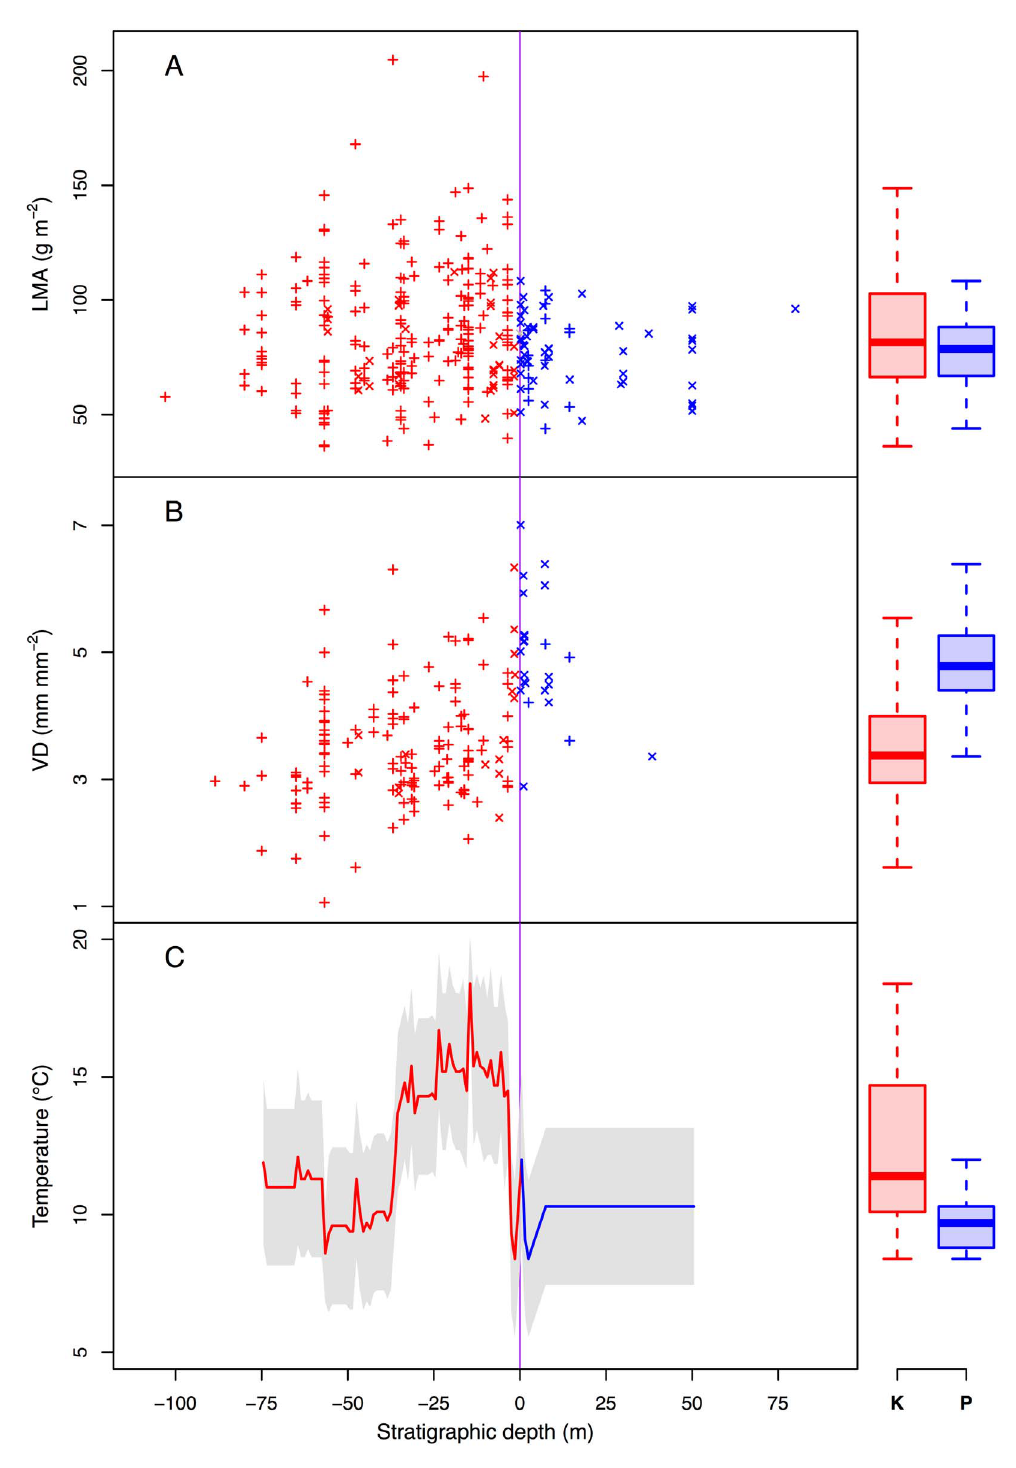
Figure 2. Changes in leaf functional traits and climate across the KPB (purple vertical line). (A) LMA reflects leaf carbon investment, with lower values associated with deciduous species. (B) VD reflects carbon assimilation capacity, with higher values associated with deciduous species. For (A) and (B), each symbol is a species at site mean: + , channel facies; x, floodplain facies. (C) Changes in temperature reconstructed previously from leaf-margin analysis of the same floras [20]. Color indicates stratigraphic depth, with red for Cretaceous data and blue for Paleogene data. Boxplots of each distribution are shown in the right margin.